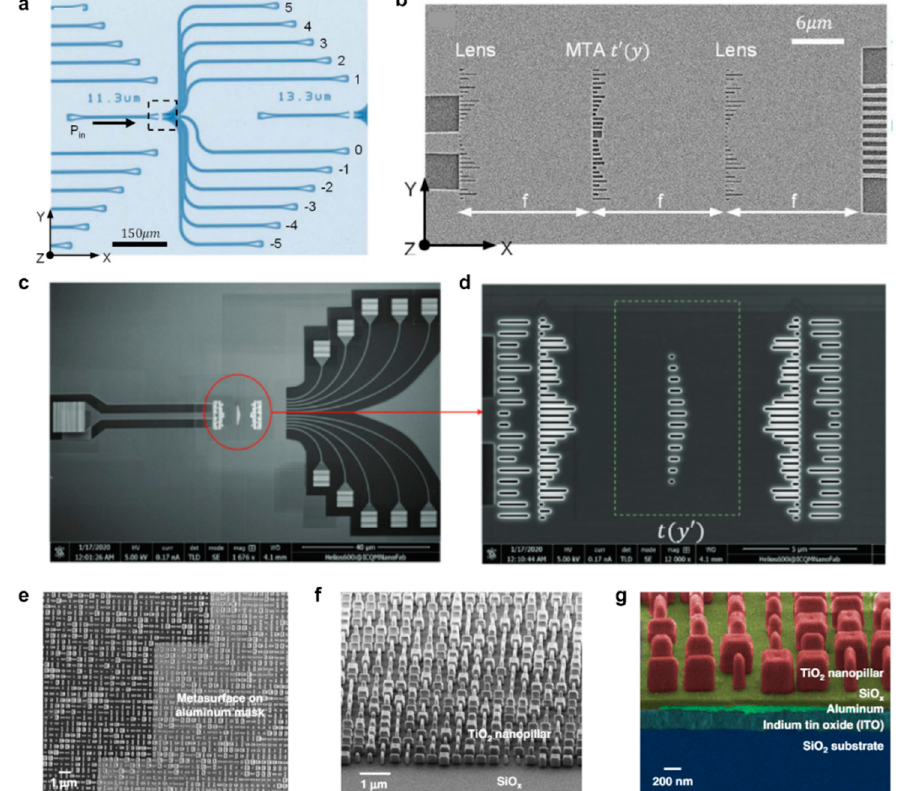
Figure 9. Computing Based on Metasurfaces. ( a ) Top view of an on-chip metalens structure. The input light is fed through the waveguide on the left. As the light passes through the microlens, the output is collected through single-mode waveguides at different spatial locations [83]. ( b ) The SEM image of the three-layer meta-system can perform the spatial differentiation of the input signal [83]. ( c , d ) Overall view of the SEM image of the on-chip nanophotonic convolver and characteristic structure of this device [84]. ( e – g ) Top-view, oblique-view, and false-color cross-sectional view of the scanning electron microscope (SEM) images, respectively, of the MDNN [32]. ( a , b ) Adapted from Ref. [83]. CC BY 4.0. ( c , d ) Adapted from Ref [84] . CC BY 4.0. ( e – g ) Adapted from Ref [32]. CC BY 4.0.